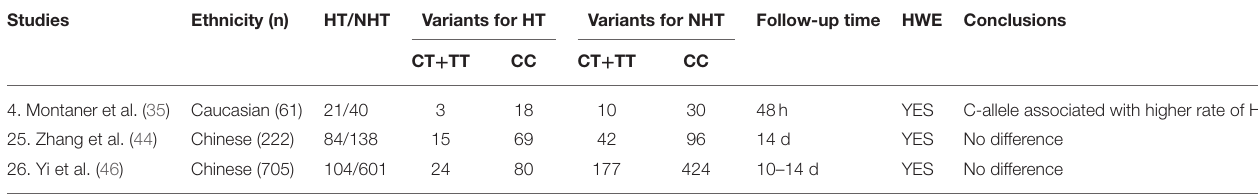
TABLE 2 | Main results of included studies of MMP-9 rs3918242 polymorphism and HT risk. Studies Variants for HT Variants for NHT Follow-up time HWE Conclusions